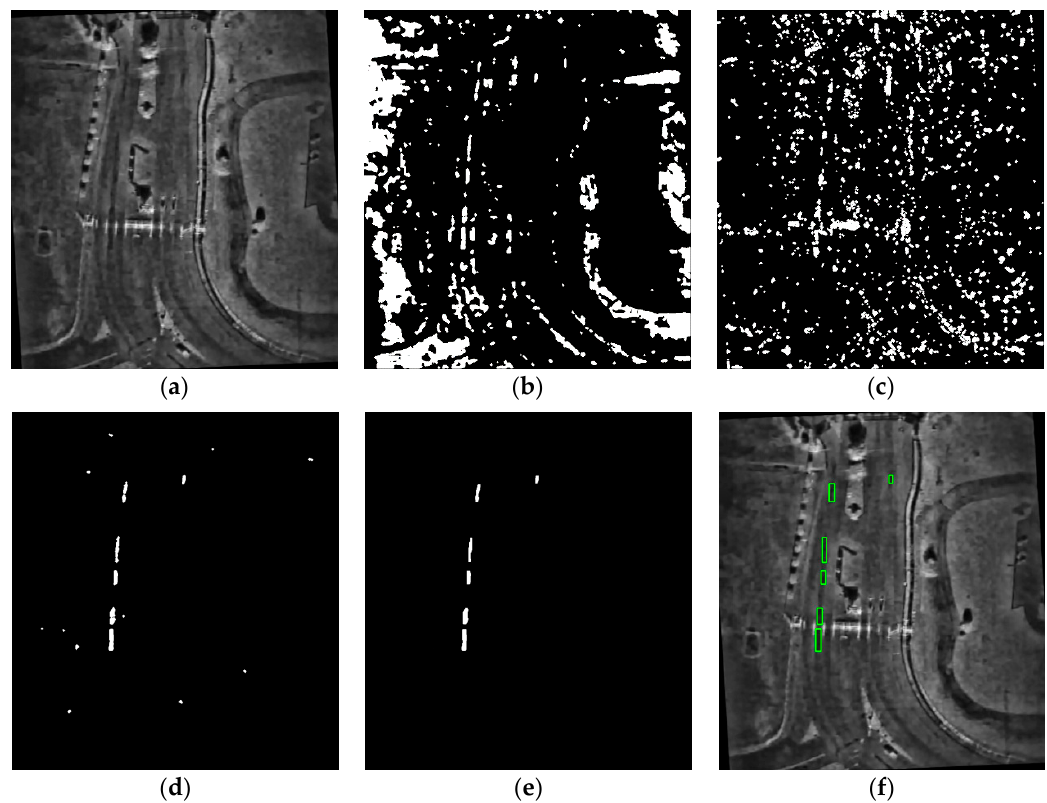
Figure 6. The results of processing of the 23rd frame. The green rectangles highlight the detected moving targets. ( a ) Results of preprocessing. ( b ) Results of background frame detection. ( c ) Results of multi-interval frame difference. ( d ) Results of fusion. ( e ) Results of false alarm suppression. ( f ) Final MTD results.